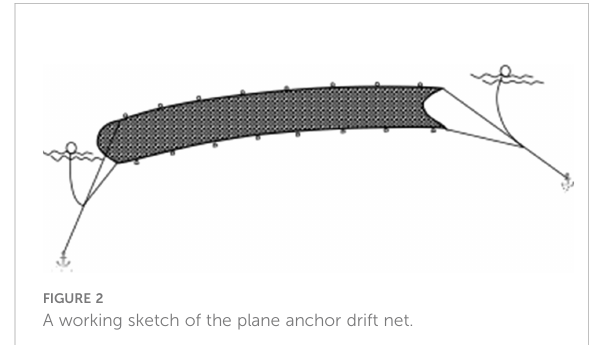
FIGURE 2 A working sketch of the plane anchor drift net.